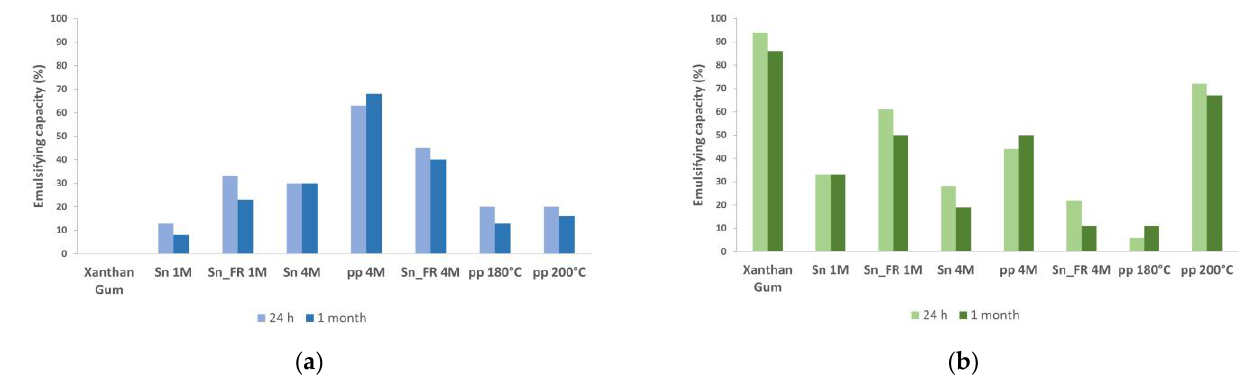
Figure 1. Emulsifying capacity at 24 h and at 1 month of xanthan gum and BSY extracts, at a concentration of 22.5 mg/mL, when applying: ( a ) hand-shaking; ( b ) ultraturrax.